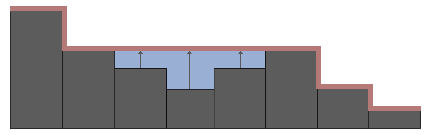
Figure 2. The pit removal by filling method (Bartak, 2009)